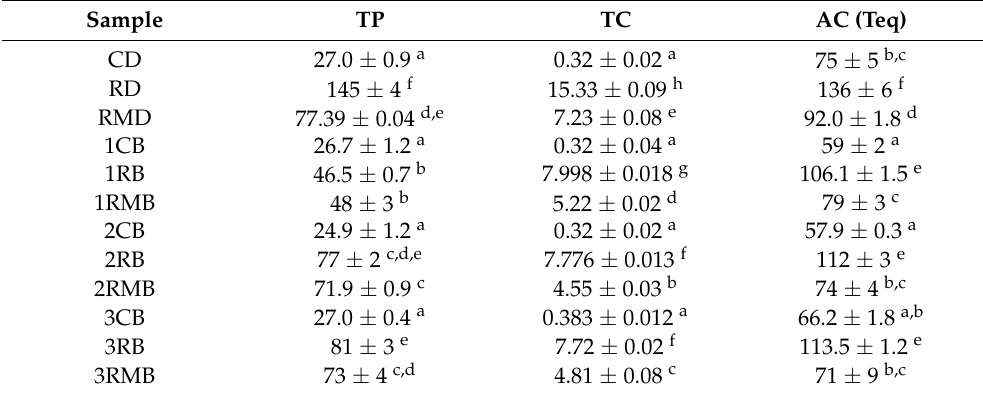
Table 6. Result of the bioactive content expressed in mg/100 g dry sample for; TP, total phenols; AC, antioxidant capacity; TC, total